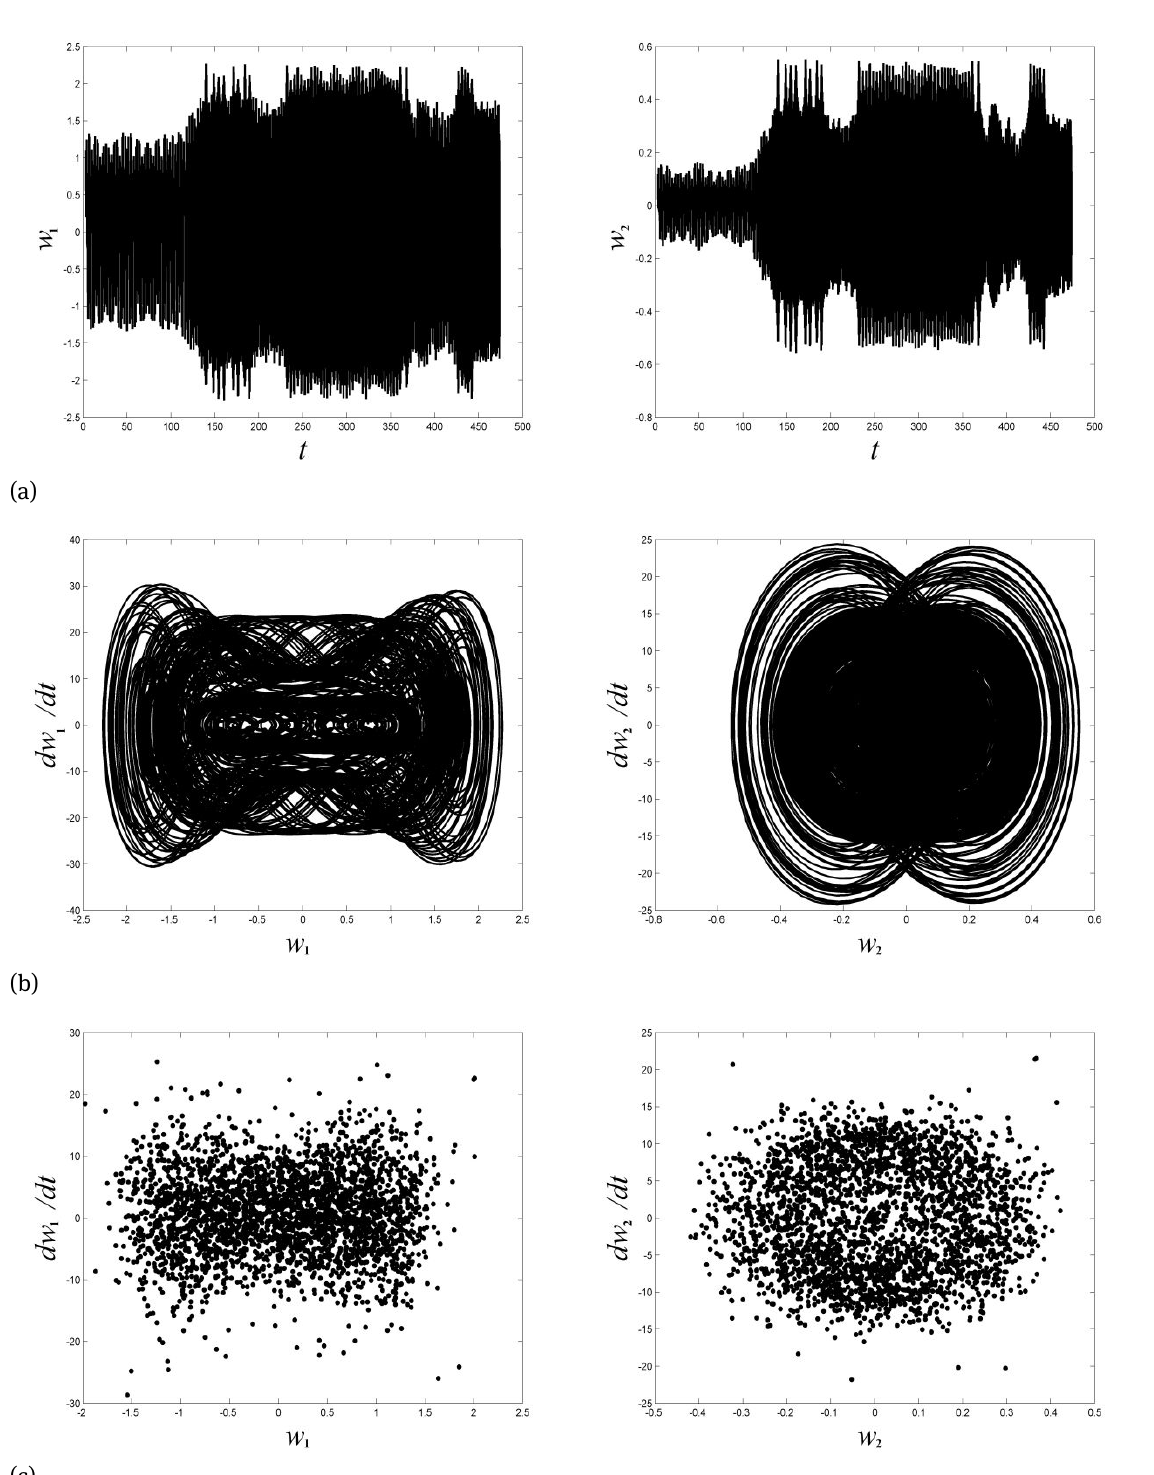
Fig. 7. Chaotic behaviors of the cantilever beam system shown in wave diagrams (a), phase diagrams (b) and Poincaré maps (c). q = 5500sin(20 πt )( Pa ) and e c = 8.28 × e 9 (cid:0) N / Nm 2 (cid:1)